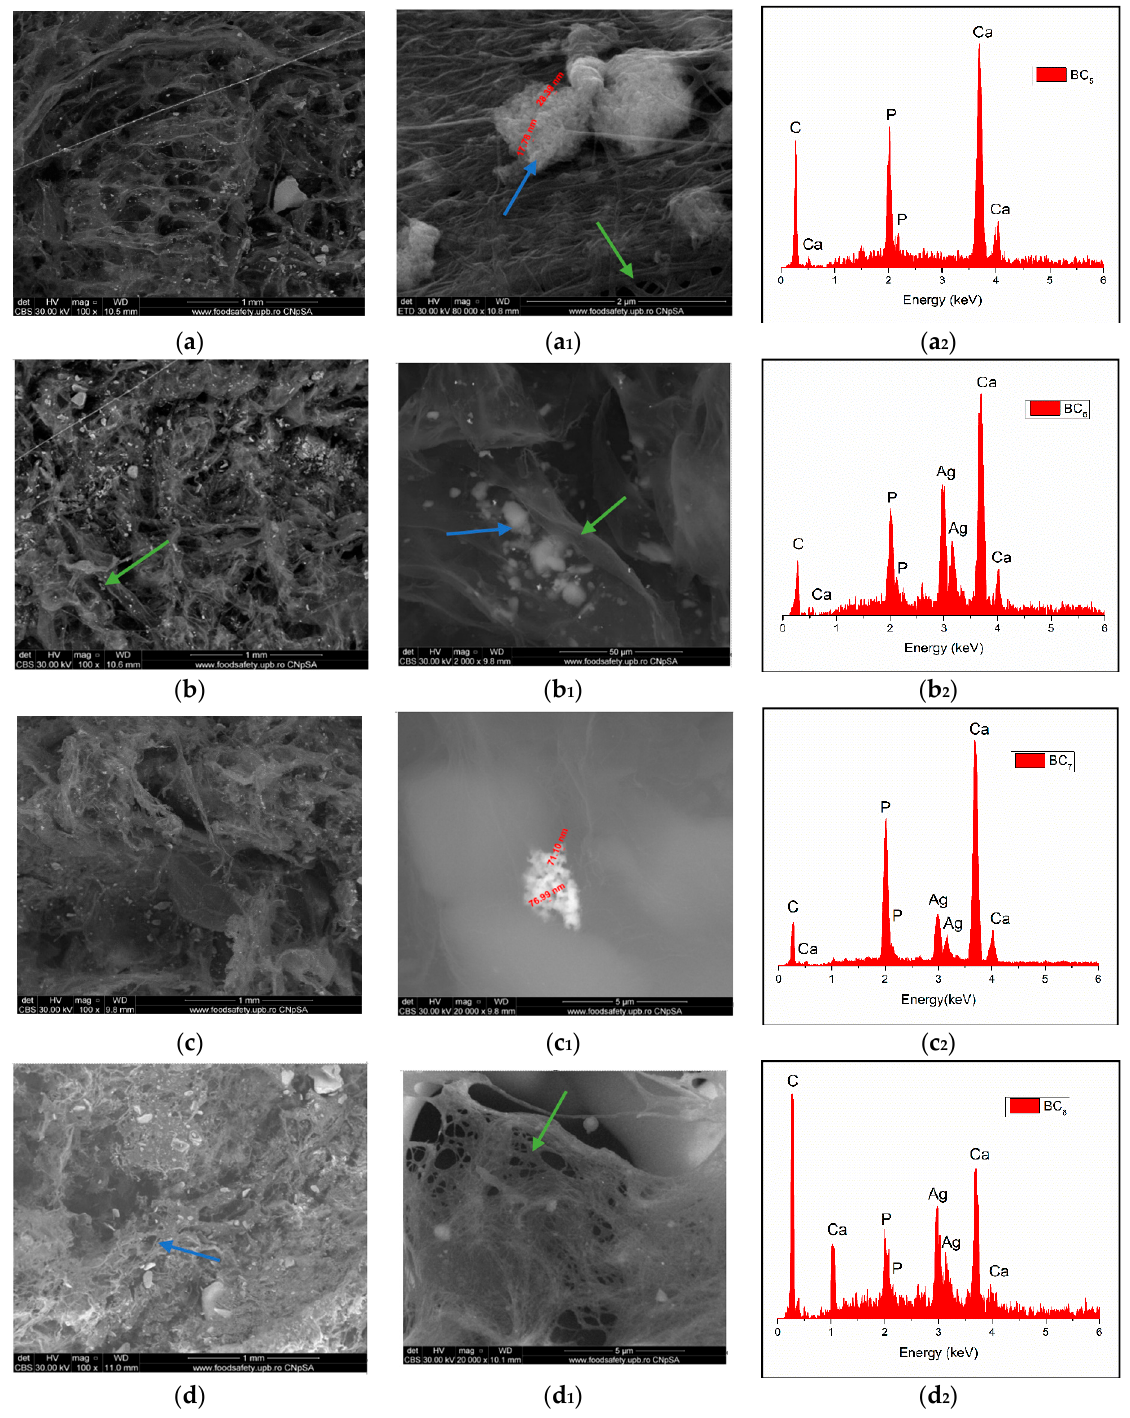
Figure 8. High-resolution backscattered electron (BSE) images and EDS spectra at 100× magnification for BC 5 ( a , a 1 , a 2 ), BC 6 ( b , b 1 , b 2 ), BC 7 ( c , c 1 , c 2 ), and BC 8 ( d , d 1 , d 2 ) (where a 1 – d 1 images represent a high magnification of a–d image area; green arrow indicates the fibrous structure of BC and blue arrow indicate inorganic particles).